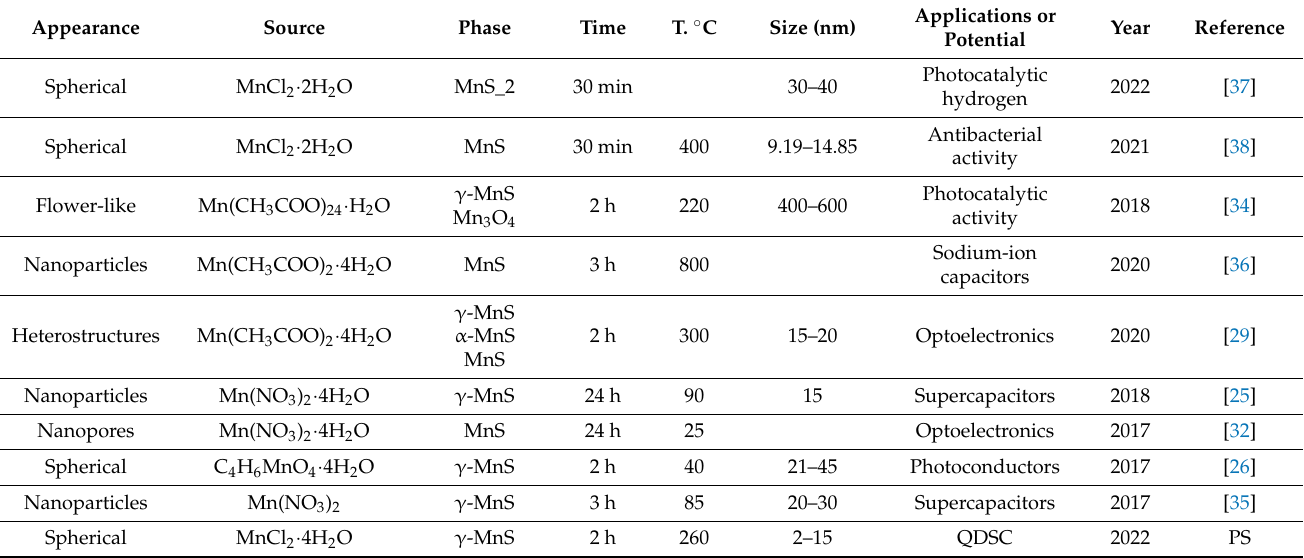
Table 1. Application of MnS nanoparticles prepared from different metal source. PS = present